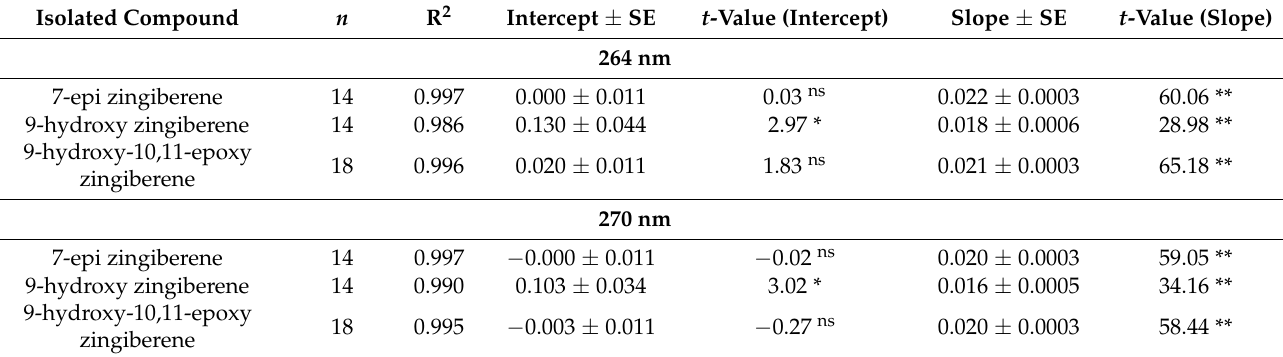
Figure 4. Linear relationships between absorbance measured at 264 nm and compound concentration (ng/µL) for fractions of 7-epi zingiberene and its two oxidized forms isolated by silica gel chromatography. Table 2. Results of regression of absorbance at 264 nm and 270 nm on GC-FID detector response for fractions of 7-epi zingiberene, 9-hydroxy zingiberene, and 9-hydroxy, 10,11 epoxy zingiberene isolated by silica gel chromatography. Isolated